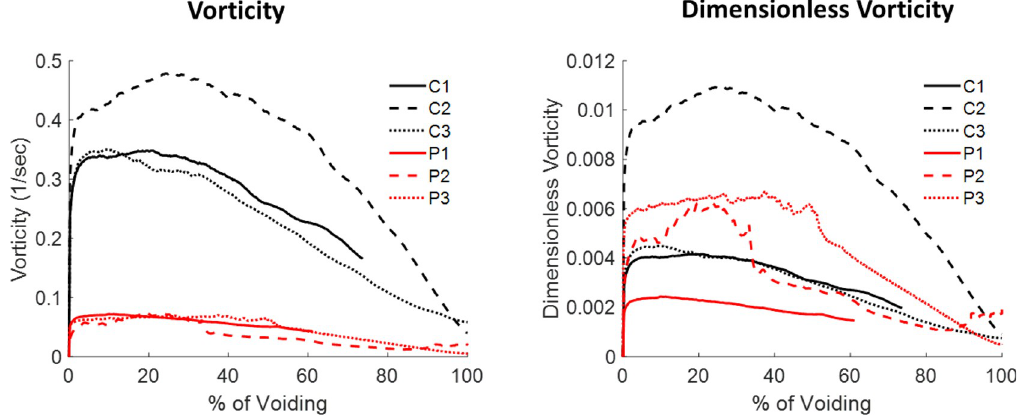
Fig 7. Bladder vorticity was lower for the men with BPH/LUTS due to their lower flowrates and urine velocities. After making vorticity dimensionless (a normalization to account for different flow rates between subjects), vorticity was similar for both